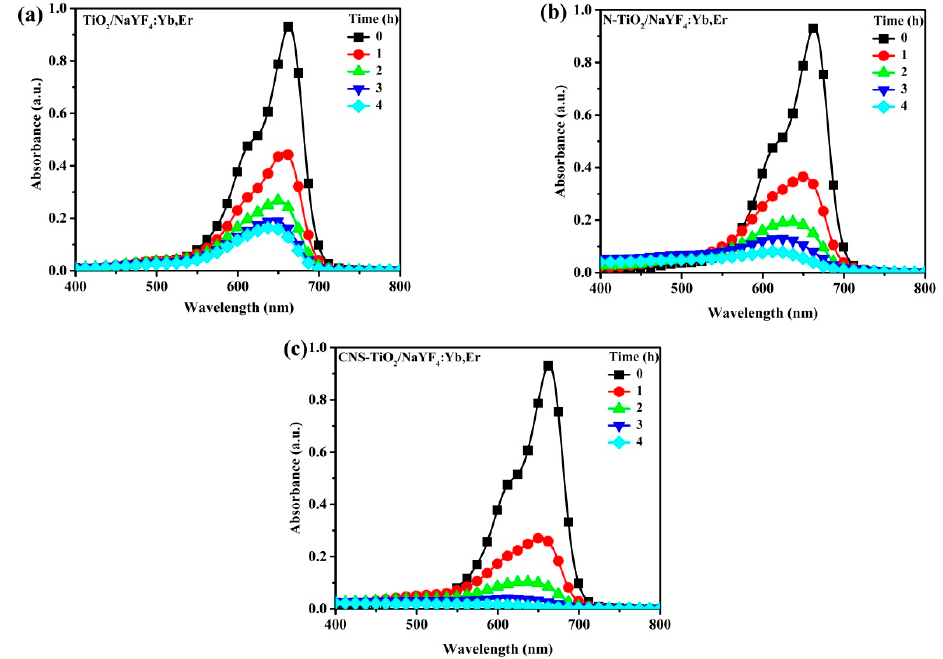
Figure 6. Methylene blue (MB) absorbance variation for NaYF 4 :Yb,Er phosphor coated with ( a ) TiO 2 , ( b ) N-TiO 2 , and ( c ) CNS-TiO 2 under UV light activation.